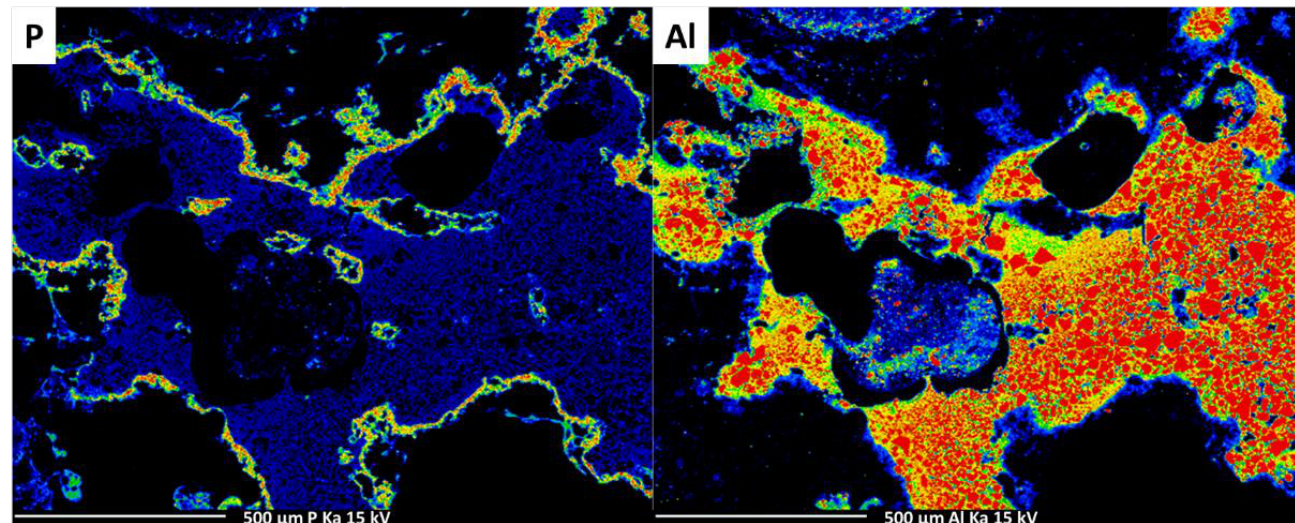
Figure 6. P and Al mapping in the AP422 SORIC laminate residue obtained after the cone calorimeter test. To identify the nature of these interactions, XRD and 31 P solid-state NMR analyses were performed on the residue (Figure 7). XRD analysis shows the presence of decompo- sition products of ATH such as aluminum oxide and boehmite (identified using the data- base), as well as the presence of aluminosphosphate (identified according to a previous study) [18]. 31 P NMR confirms the presence of this species. The spectrum of raw alumino- phosphate indeed fits one of the peaks (around − 30 ppm) in the spectrum. Other peaks are detected that have not been identified yet. The presence of aluminophosphate indi- cates a reaction between AP422 and ATH. Such a reaction has already been reported in the literature [19]. This reaction can stabilize the residue in the solid phase and form a more effective char layer. In addition, the presence of a large band between -50 and 10 ppm is detected, revealing the presence of amorphous phosphate species. This phosphate glass could also be beneficial for the cohesion of the residue. These characterizations con- sequently show that different products are formed during the combustion of the samples, which all contribute to the performances of the materials. This FR sandwich is even more efficient due to the presence of the chemical interaction occurring at the interface of the treated core material/filled resin. Figure 7. XRD analyses ( a ) and 31 P NMR spectrum ( b) of AP422 SORIC laminate residue. 3.4. Optimization of the System Different approaches to optimizing the FR materials ’ processability and weight with- out losing fire performance have been explored. The first one consists of studying the in- fluence of the FR add-on on the fire performances of the composite and the second one consists of keeping the FR add-on constant while decreasing the ATH loading.